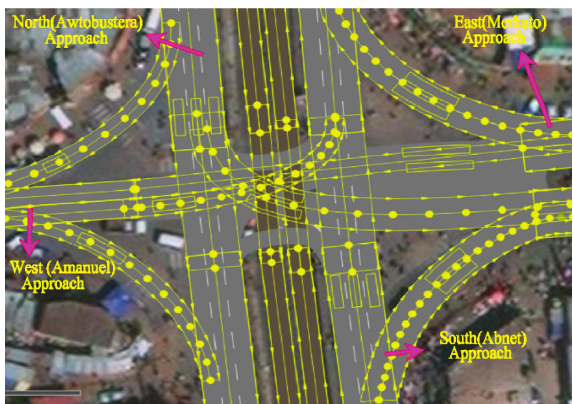
Figure 1: Snapshot of the VISSIM model with the links, splined connectors, and reduced speed areas for Sebategna